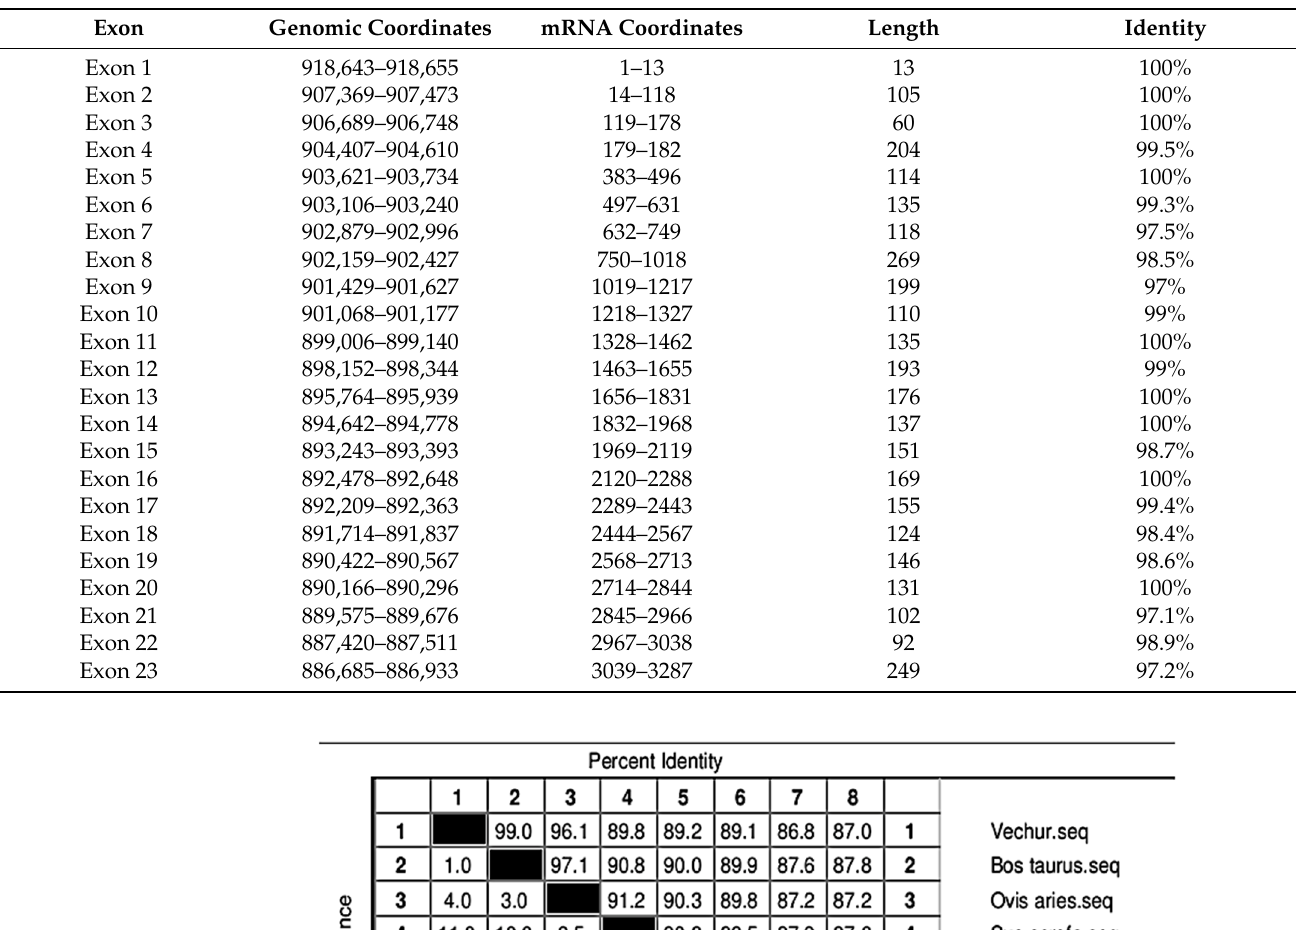
Table 3. Details of genomic structure and coordinates of ATP1A1 .